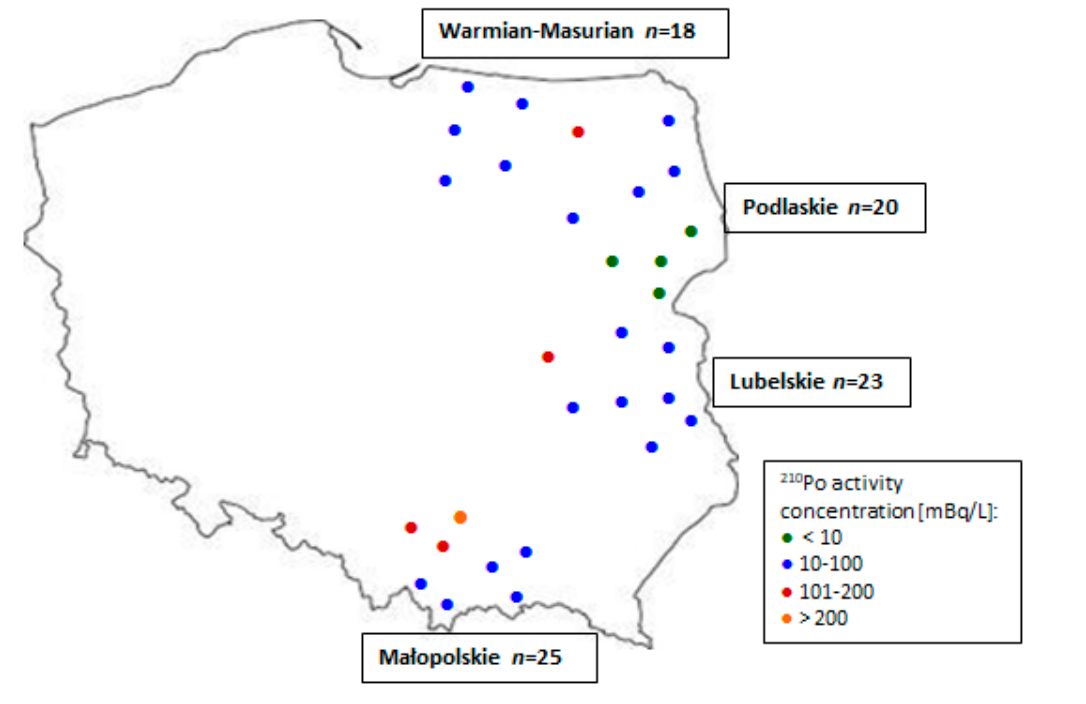
Figure 1. Categories of 210 Po activity concentration (mBq/L) in fruit wine samples derived from different locations in Poland.